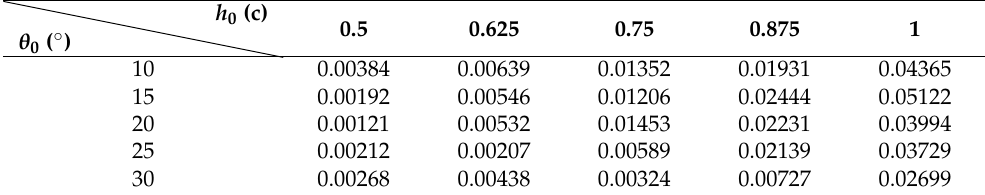
Table 2. The standard deviation of thrust coefficient of different heave motion amplitudes and pitch amplitude curves.